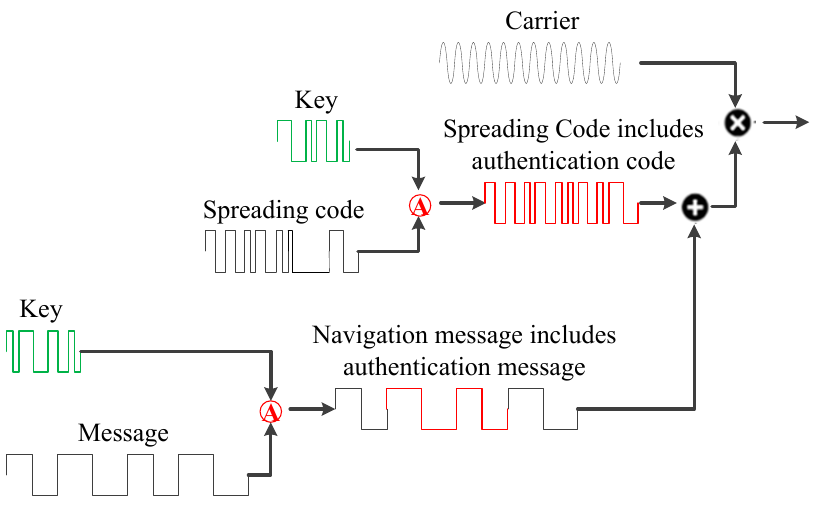
Figure 1. Satellite Navigation Signal Authentication.